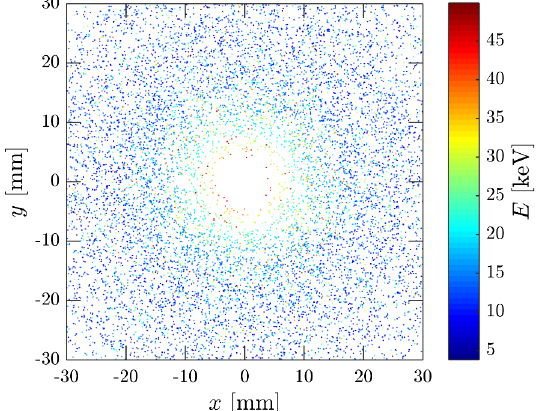
FIG. 2. Scatter plot of the location ð x; y Þ and energy E of photons arriving in the plane of the detector for the case of diffraction by powdered silicon of an x-ray beam with a 20 keV and σ 2 . 5 mrad. synchrotron spectrum of E φ ¼ c ¼ The number of photons used in the simulation was N 1 × 10 5 sim ¼